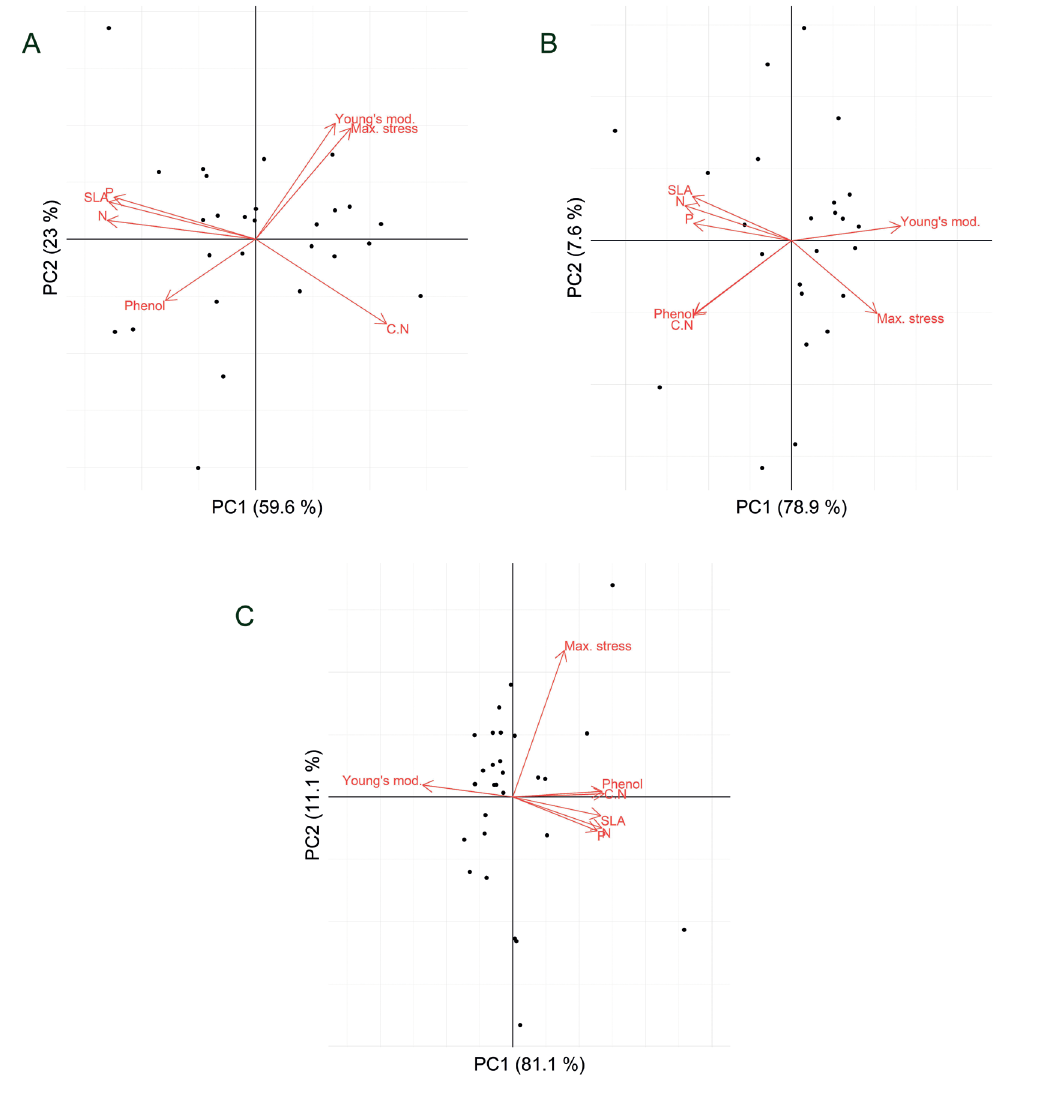
Figure 2 – Principal Component Analysis performed with silver fir ( A ), Norway spruce ( B ) and beech ( C ) data. Variables tested are SLA, C:N ratio, N and P content, phenolic content, Young’s modulus and maximum stress. PC1 and PC2 respectively stand for 1 st and 2 nd principal